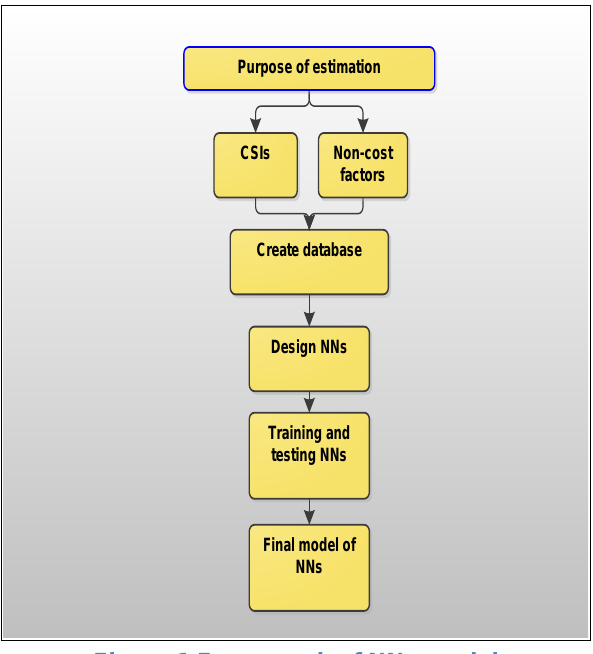
Figure 1 Framework of NNs